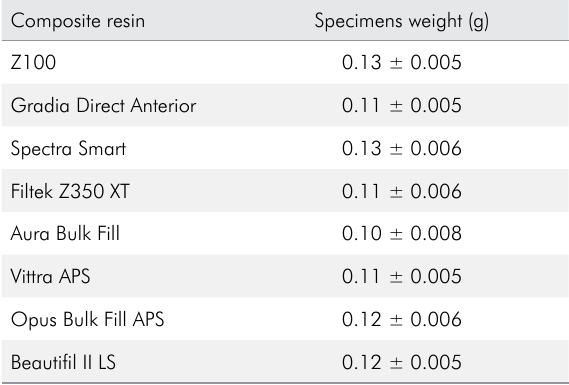
Table 2. Specimens weight (mean ± standard